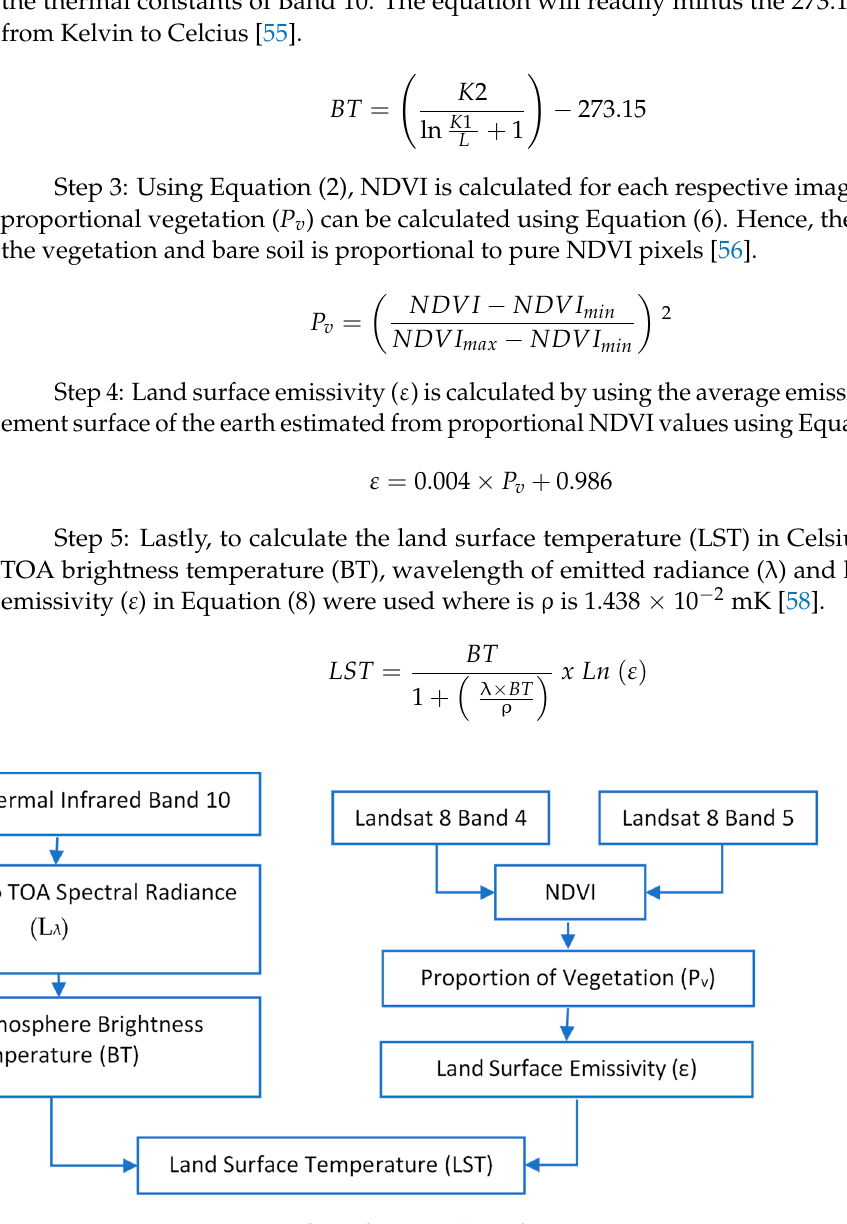
Figure 4. Derivation of LST from Landsat 8/OLI.